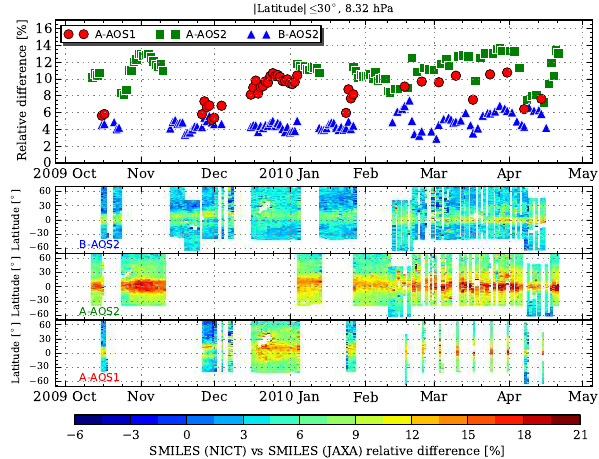
Fig. 10. Seasonal and latitudinal variation of SMILES(NICT) and SMILES(JAXA) O 3 differences, shown in the same figure format as Fig.7.